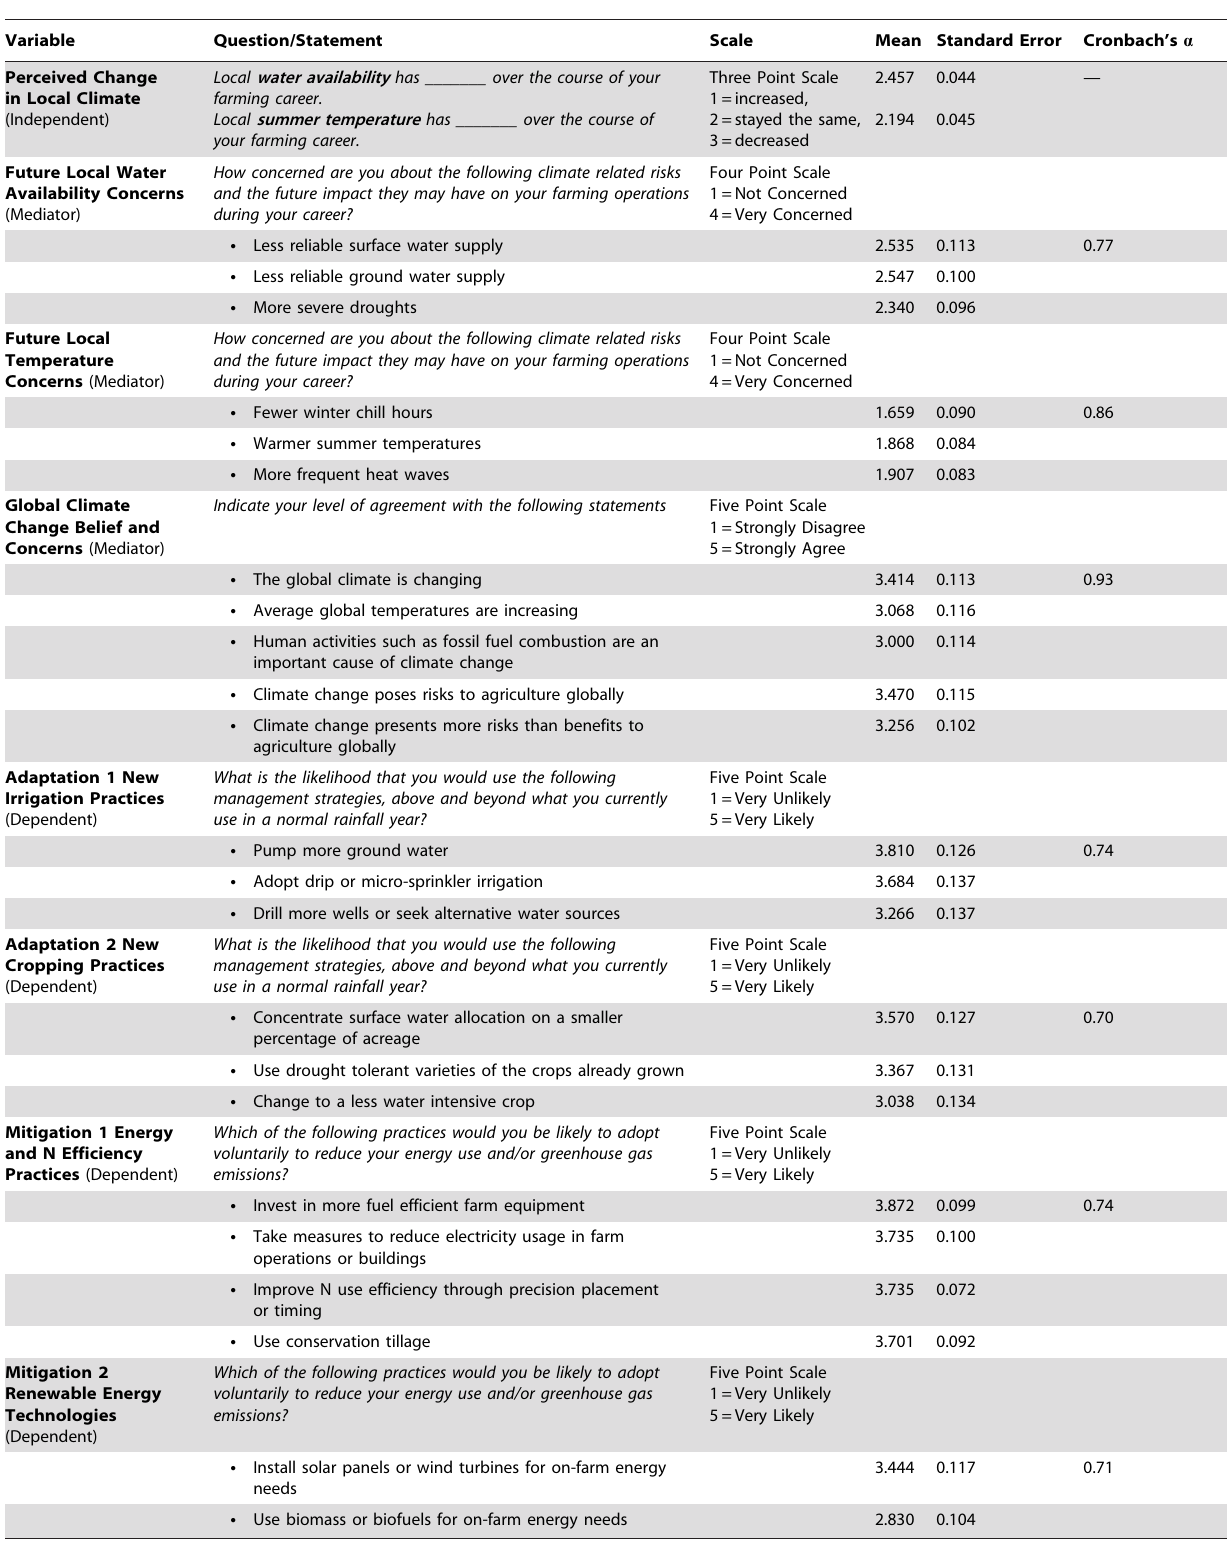
Table 1. Survey questions, scales, mean values, standard errors and reliability coefficients (Cronbach’s a ) for variables used in the multiple-mediation